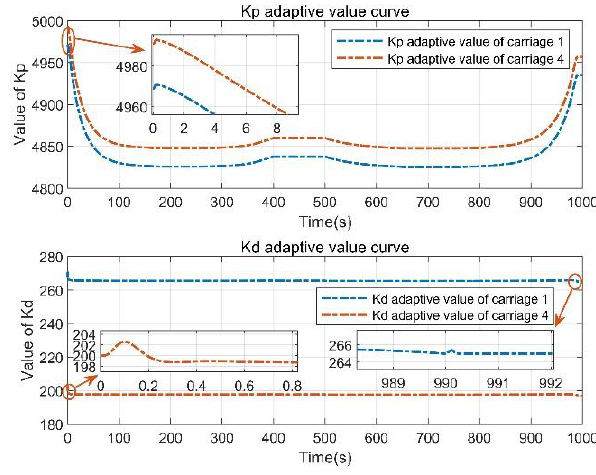
Figure 11. k p and k d adaptive values. Figure 11. p k and d k adaptive values.